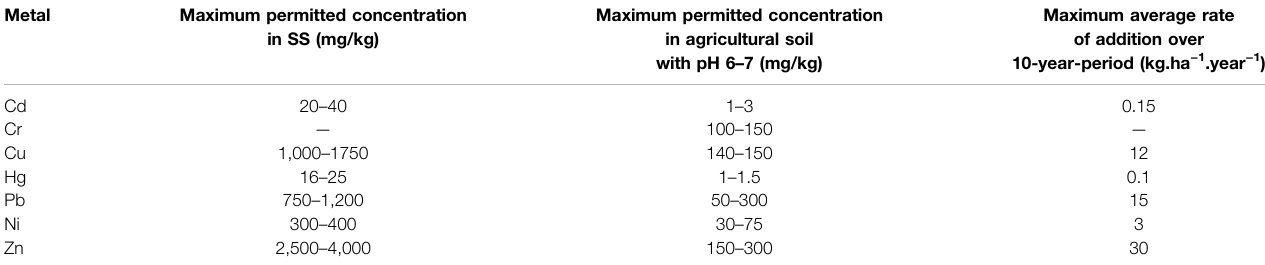
TABLE 5 | Maximum values of metal content in SS used in agriculture, their rate of application, and concentration in sludge-treated soils in the Commission of the European Communities directive (Commission of the European Communities et al., 2009). Metal Maximum permitted concentration Maximum permitted concentration in SS (mg/kg) in agricultural soil